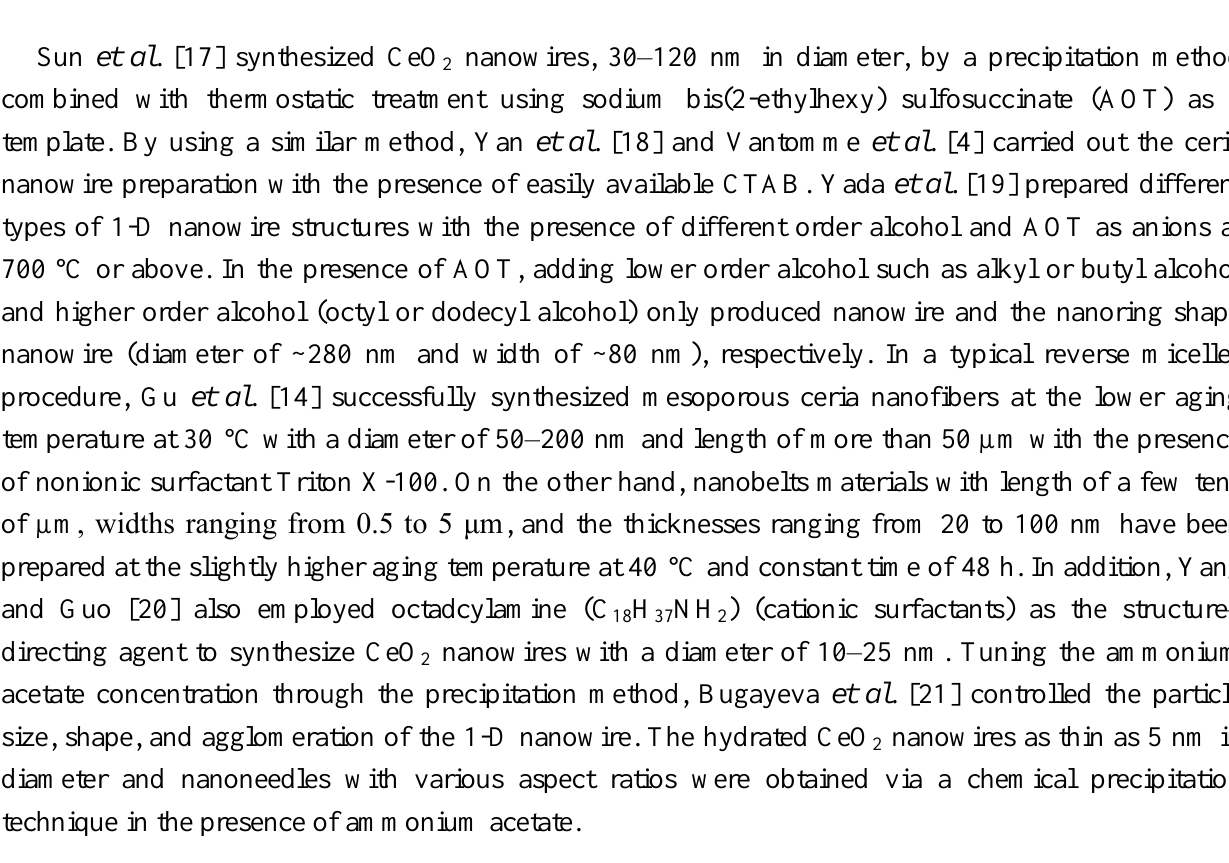
nanowires formed by using anodic alumina 2